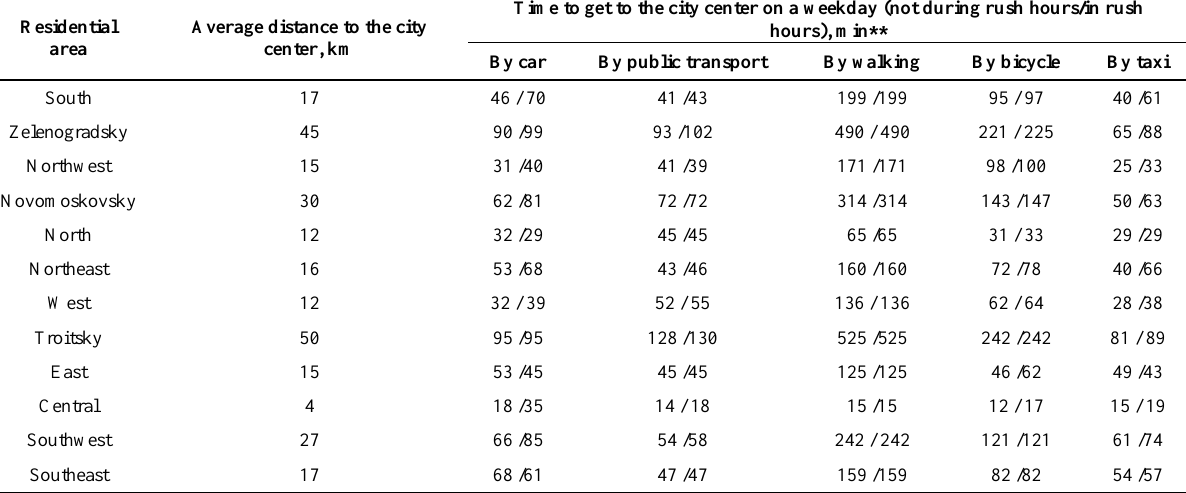
Table 3. Assessment of OA indicators by the time and distance o get from Moscow's districts to the city center (* Red Square is taken as the city center; ** according to [55]). Residential